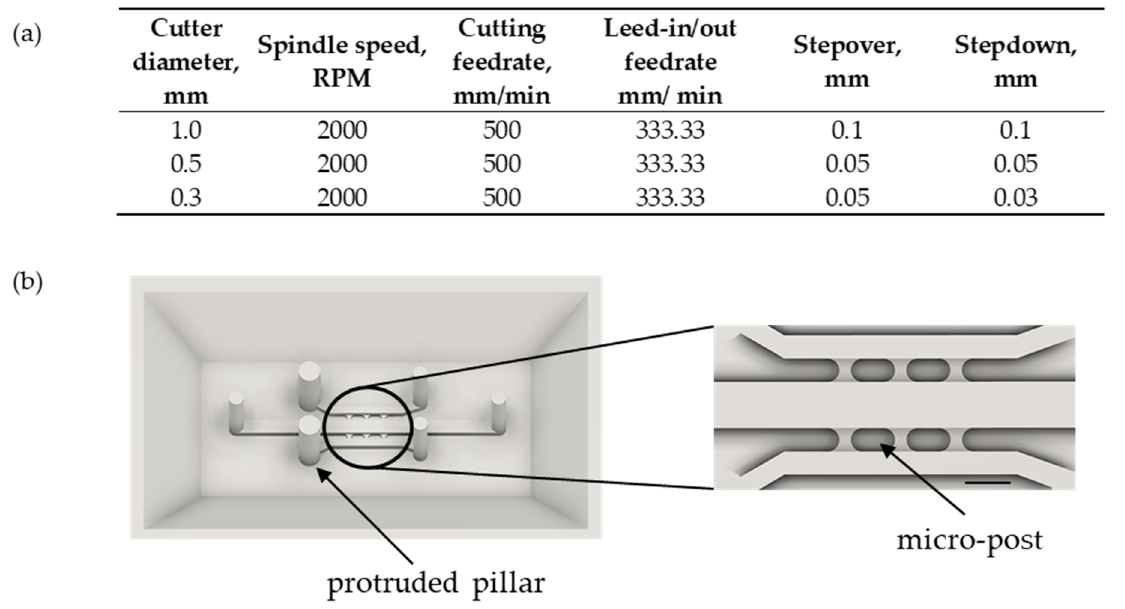
Figure 1. ( a ) Micro-milling parameters. ( b ) Exemplary mold with protruded pillars. Scale bar: 1000 µm.